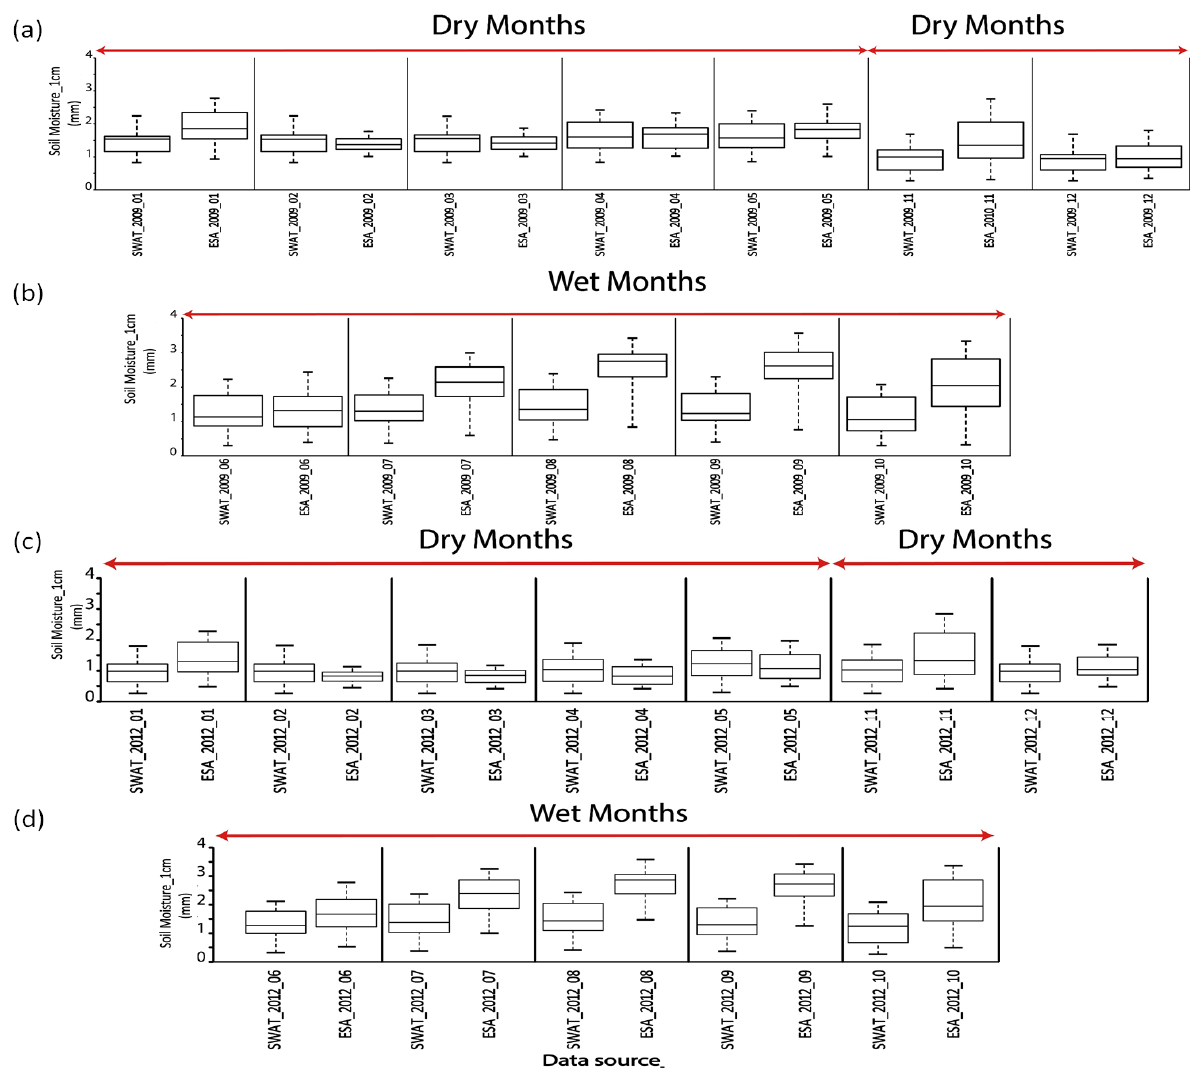
Figure 7. Seasonal comparison between monthly averaged SWAT and ESA CCI SSM at 1 cm on 2009 as driest year: ( a ) dry months, ( b ) wet months and on 2012 as wettest year: ( c ) dry months, and ( d ) wet months.